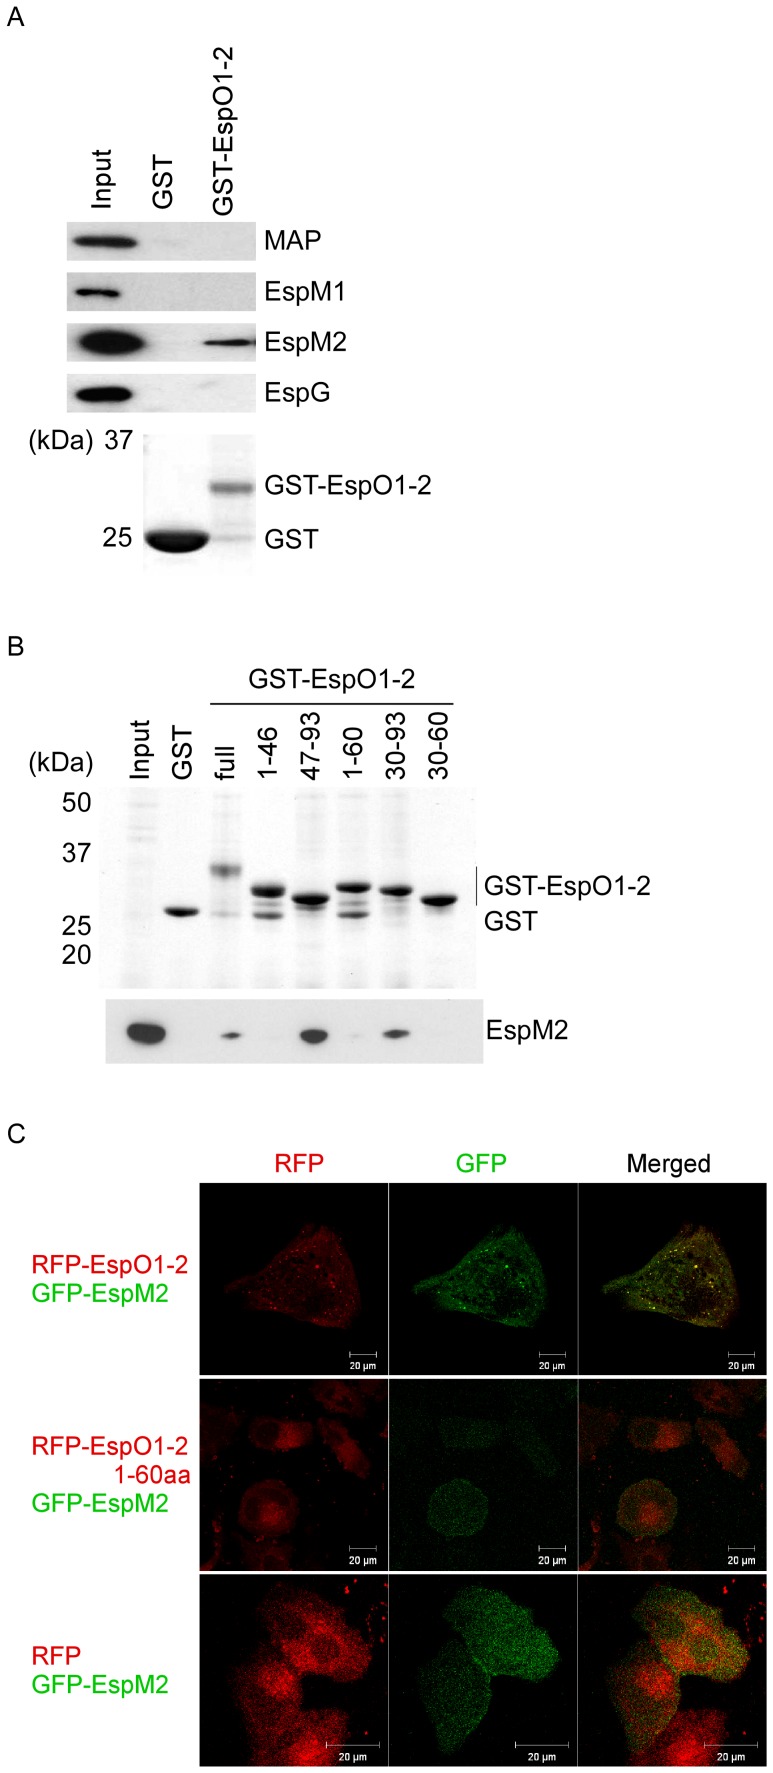
Interaction of EspO1-2 with EspM2.(A) GST-EspO1-2 binding assays were performed using cell lysates expressing Flag-tagged Map, EspM2, EspM2 or EspG. Proteins that bound to GST-EspO1-2 and GST-alone were analyzed by SDS-PAGE followed by immunoblotting with anti-Flag antibody. (B) To map the EspM2-binding site in EspO1-2, a series of truncated GST-EspO1-2 peptides was used in binding assays with cell lysate expressing Flag-tagged EspM2. (C) Co-localization of RFP-EspO1-2 and GFP-EspM2 in HeLa cells. HeLa cells were transfected with pRFP-EspO1-2, pRFP-EspO1-2 1–60aa or pRFP (red) and pEGFP-EspM2 (green).